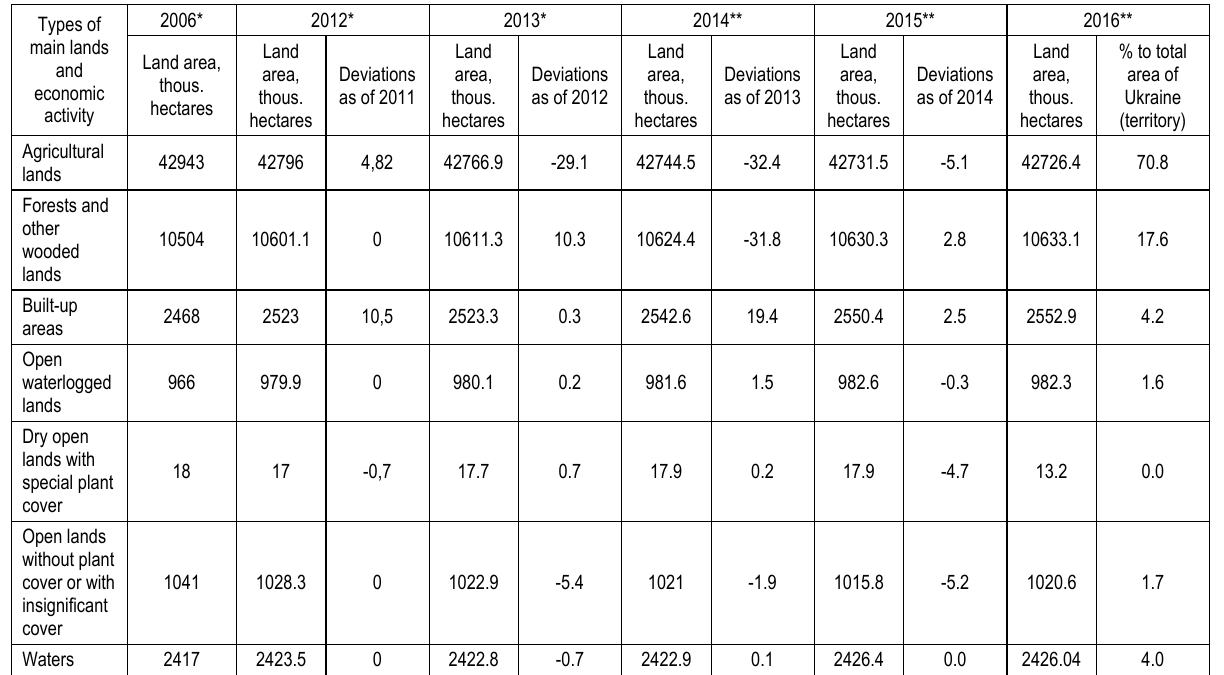
Table 1. Dynamics of land resources in 2006 and 2012-2016